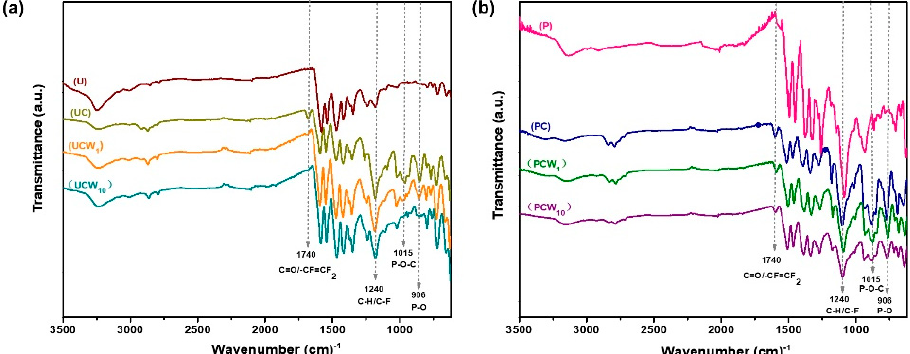
Figure 4. Attenuated Total Reflection ‐ Fourier Infrared Spectrometer (ATR ‐ FTIR) spectrum of aramid fabric samples after various coating and washing processes: ( a ) U, UC, UCW 1 , and UCW 10 , and ( b ) P, PC, PCW 1 , and PCW 10 .